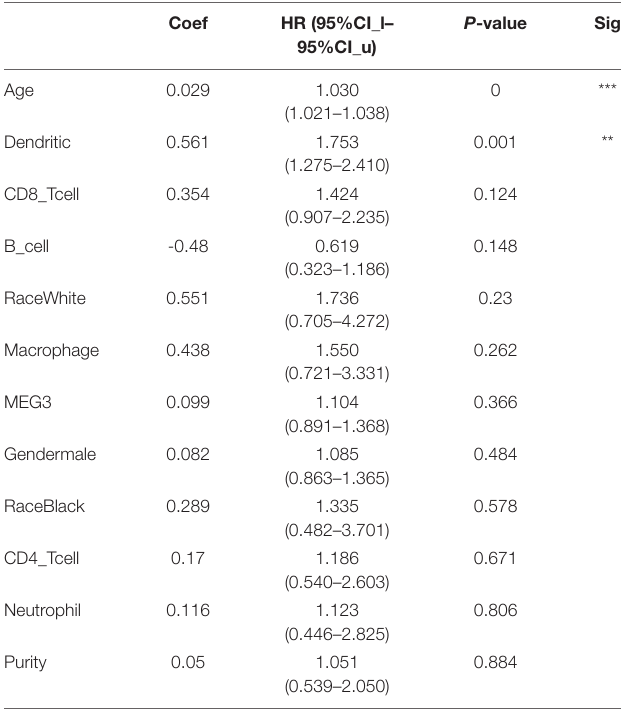
TABLE 4 | Multivariate analysis of the correlation of MEG3 expression and immune infiltrates with OS in GBM.